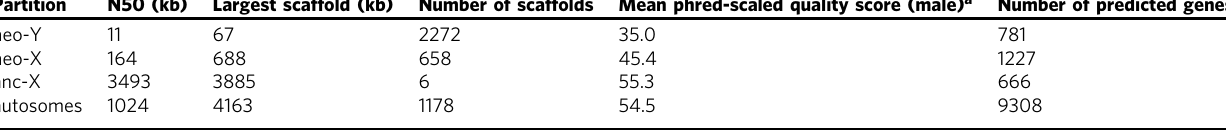
Table 1 Genome assembly statistics by genomic